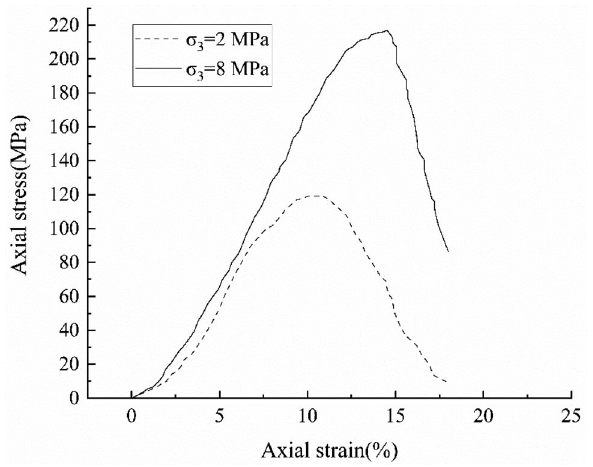
Figure 3. Stress–strain curves of the